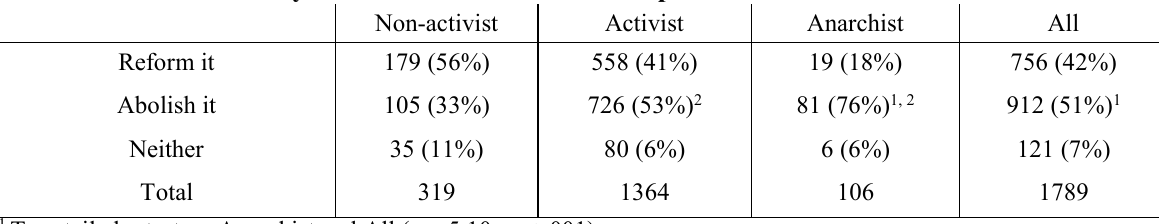
Table 4: Attitudes toward capitalism